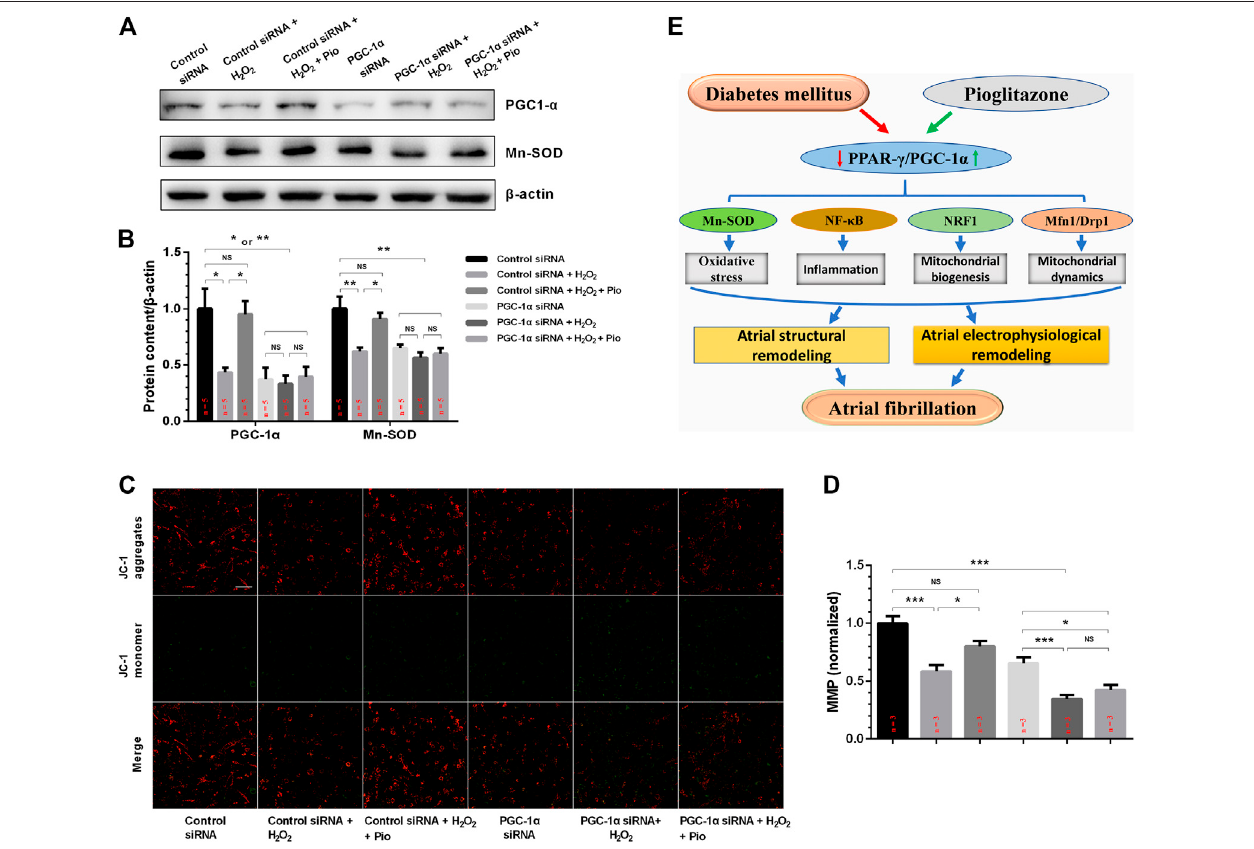
FIGURE6| PGC-1 α siRNA bluntedthe effect ofpioglitazone(Pio) on Mn-SOD protein expression and mitochondrial membrane potential (MMP) collapse inH 2 O 2 - treatedHL-1cells. (A) RepresentativeWesternblottingresults. (B) Quanti fi cationofproteinexpression.Valuesarepresentedasmean ± SEM.* p < 0.05;** p < 0.01;NS, not signi fi cant. n (cid:2) 5 independent experiments. (C) Representative confocal microscopy images of HL-1 cells that were stained with JC-1 dye. (D) Quanti fi cation of (C) . n (cid:2) 3 independent experiments (scale bar (cid:2) 100 μ m). (E) Schematic fi gure illustrating that pioglitazone prevents diabetes-induced mitochondrial oxidative stress and atrial remodeling through the PPAR- γ /PGC-1 α